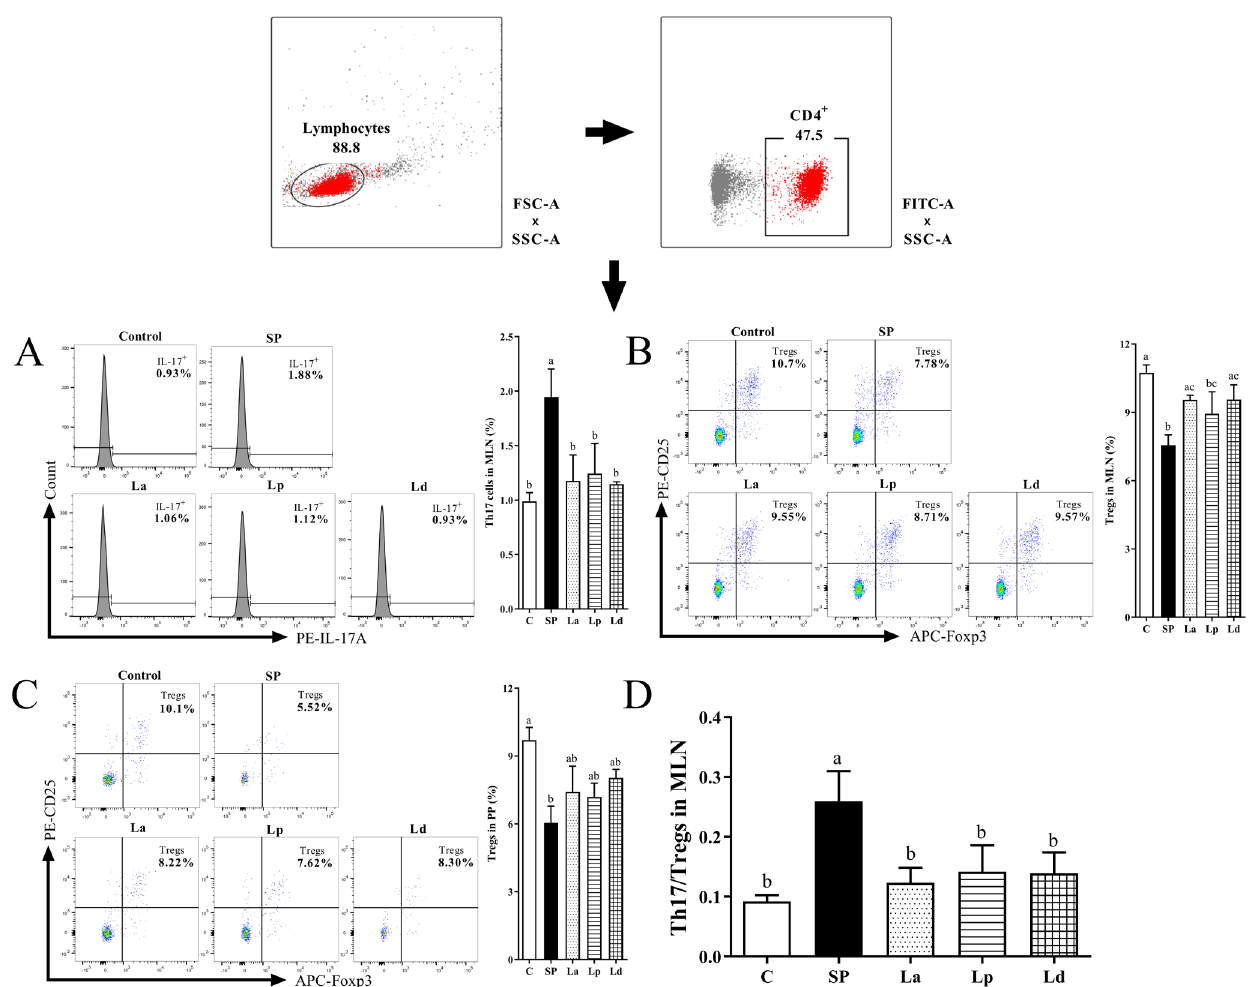
Figure 6. Effect of Lactobacillus on Th17/Tregs balance in MLNs and PPs of soy-allergic mice. The graph shows the percentage of Th17 cells among CD4 + T cells in MLNs ( A ), the percentage of Tregs among CD4 + T in MLNs ( B ) and PPs ( C ) of mice. Th17/Tregs ( D ) in MLNs of mice was analyzed. Different letters denote statistically significant differences ( p < 0.05).